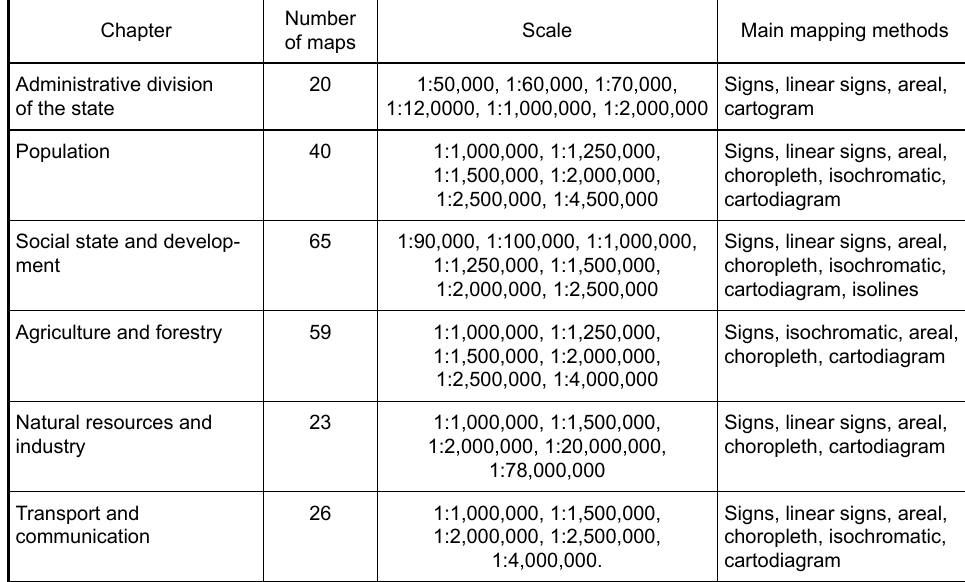
Table 2. Methods of mapping and map scales of third volume of the National Atlas of Lithuania